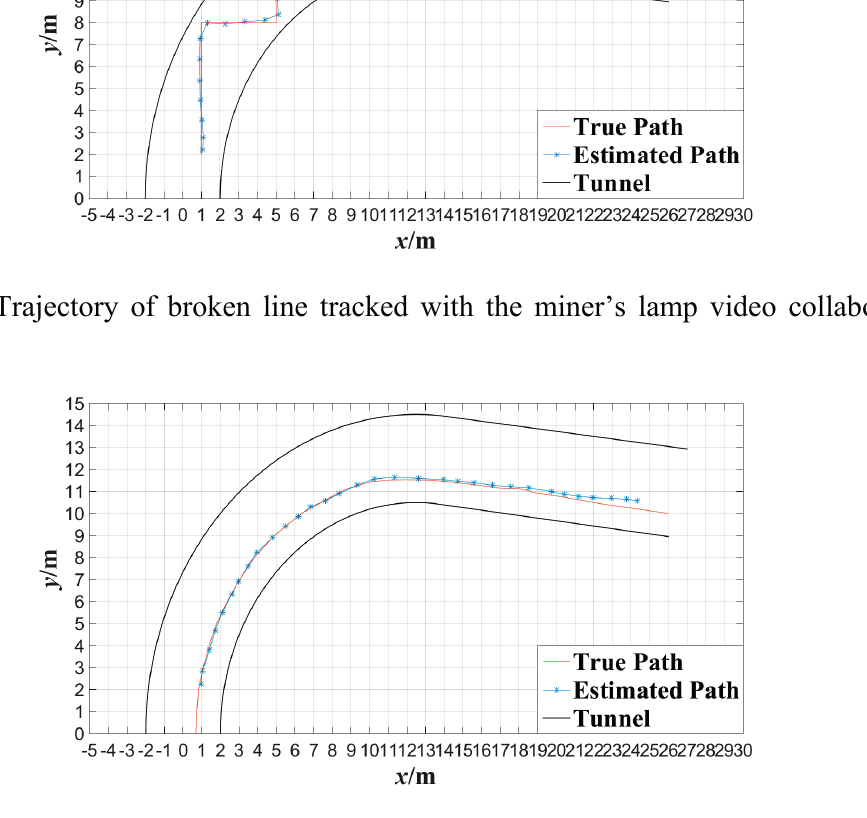
Figure 17. Trajectory of curved line tracked with the miner’s lamp video collaborative